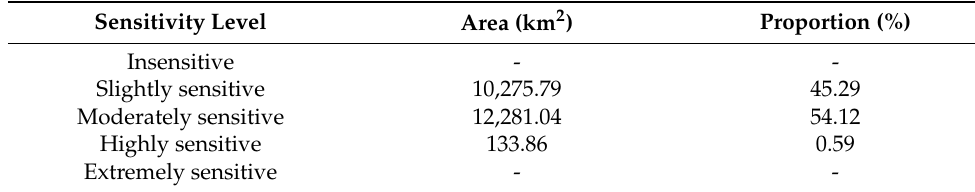
Figure 6. Distribution of ecological sensitivity. Table 7. Comprehensive ecological sensitivity analysis